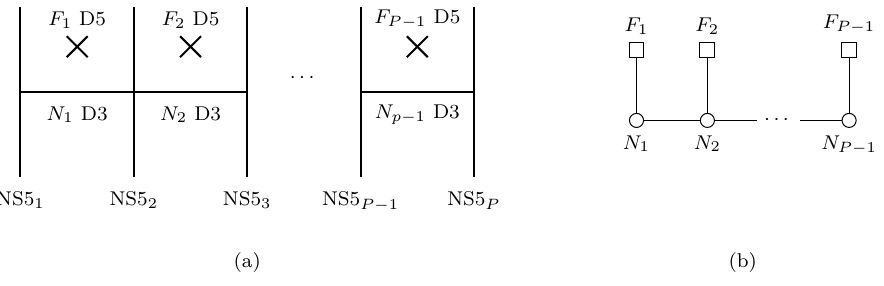
Figure 1 . The Hanany-Witten brane set up, showing the N k (colour) D3 branes, the F k (flavour) D5 branes and the NS5 branes. The associated quiver field theory is also